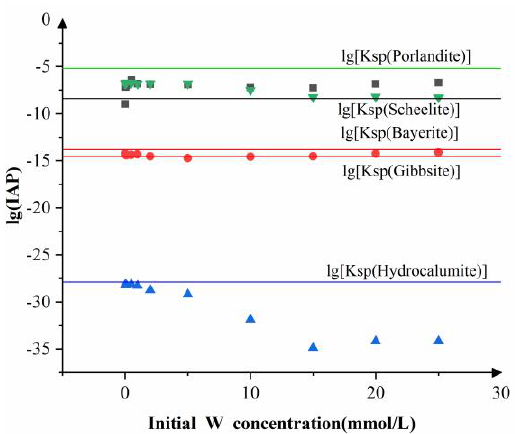
Figure 6. Solubility product constants for minerals in the reaction system versus the activity products of the corresponding component ions. Symbols: (cid:78) hydrocalumite; • gibbsite or bayerite; (cid:4) scheelite; (cid:72) portlandite.